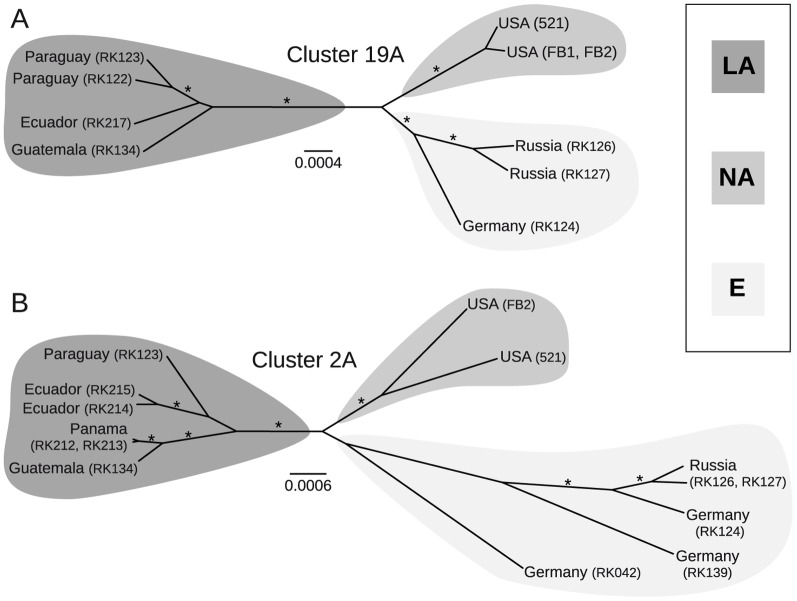
Coalescence genealogies of cluster 19A and cluster 2A sequence datasets.Coalescence-based genealogies (Beast v1.6.1) of datasets comprising (A) partial sequences of cluster 19A and (B) entire cluster 2A. Asterisks above branches correspond to a posteriori probabilities higher than 0.98. Branch lengths correspond to substitutions per site.